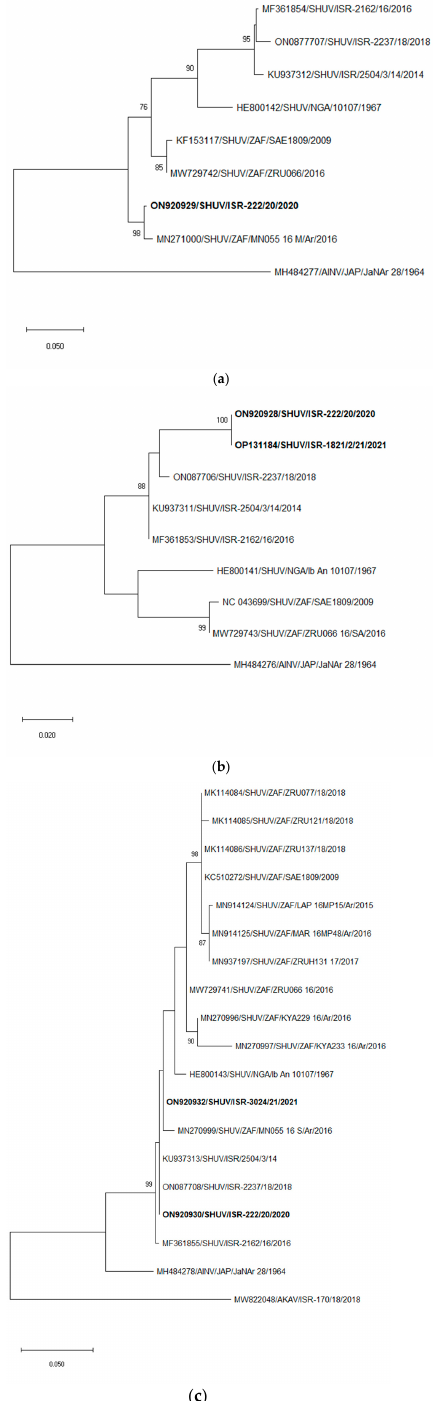
Figure 2. Phylogenetic trees of nucleotide sequences of Israeli and global SHUV. ( a ) M segment sequences; ( b ) L segment sequences; ( c ) S segment sequences. Sequences obtained in this study are in bold. Sequences obtained from the NCBI GenBank are labeled by accession number/viral species/location/isolate/year. Aino virus (AINV) was used as an outgroup for phylogenetic analyses of M and L segments, and Akabane (AKAV) virus was used as an outgroup for phylogenetic analysis of S segment sequences. Nucleotide sequences were analyzed using the maximum ‐ likelihood method and the Tamura–Nei model. Statistical support for nodes was obtained by bootstrapping (1000 replicates); only values ≥ 70% are shown. Scale bars indicate nucleotide substitutions per site.